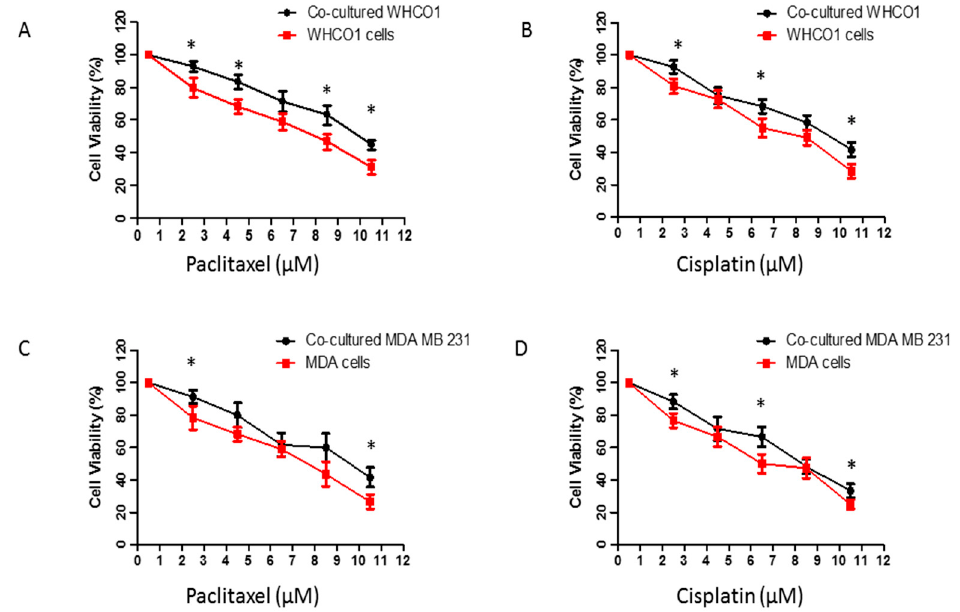
Figure 6. Co-cultured cancer cells survive treatment with cisplatin and paclitaxel better than WHCO1 and MDA MB 231 cells alone. WHCO1 and MDA MB 231 cancer cells (5 × 10 5 ) were cultured alone or co-cultured with WJ-MSCs for 16 days as described in Figure 3. Empty inserts were used for the control group (no MSCs) and a mixture of MSCs medium and cancer cell medium (1:1) was used. Medium was changed every 3 days for longer incubation periods. At the end of the incubation, the same number of WHCO1 and MDA MB 231 cancer cells were treated with increasing concentrations of paclitaxel and cisplatin for 48 h as shown above. After 48 h, cells were counted with a Countess Cell counter using the Trypan Blue exclusion method. Cells were expressed as a percentage of cells treated with 0.1% DMSO (control). Experiments were repeated three times. * p < 0.05.